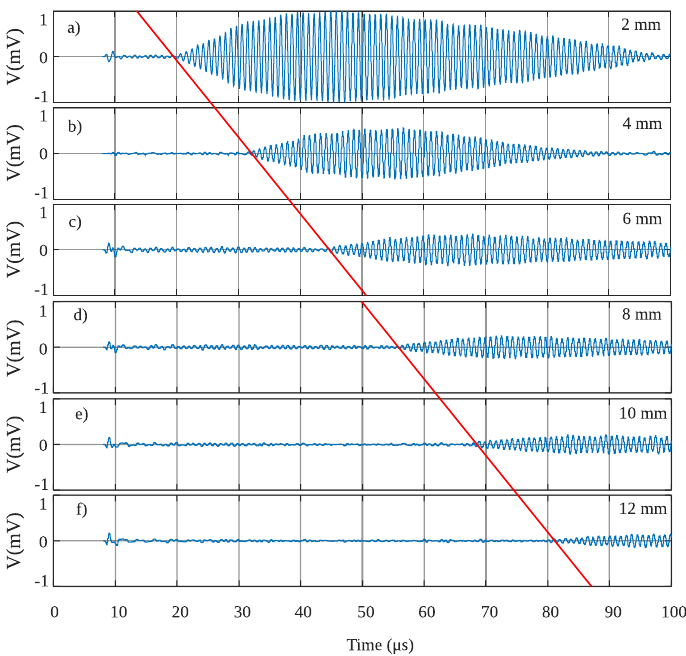
Figure 12. Ranging measurement results in the air for distances of ( a ) 2 mm, ( b ) 4 mm, ( c ) 6 mm, ( d ) 8 mm, ( e ) 10 mm, and ( f ) 12